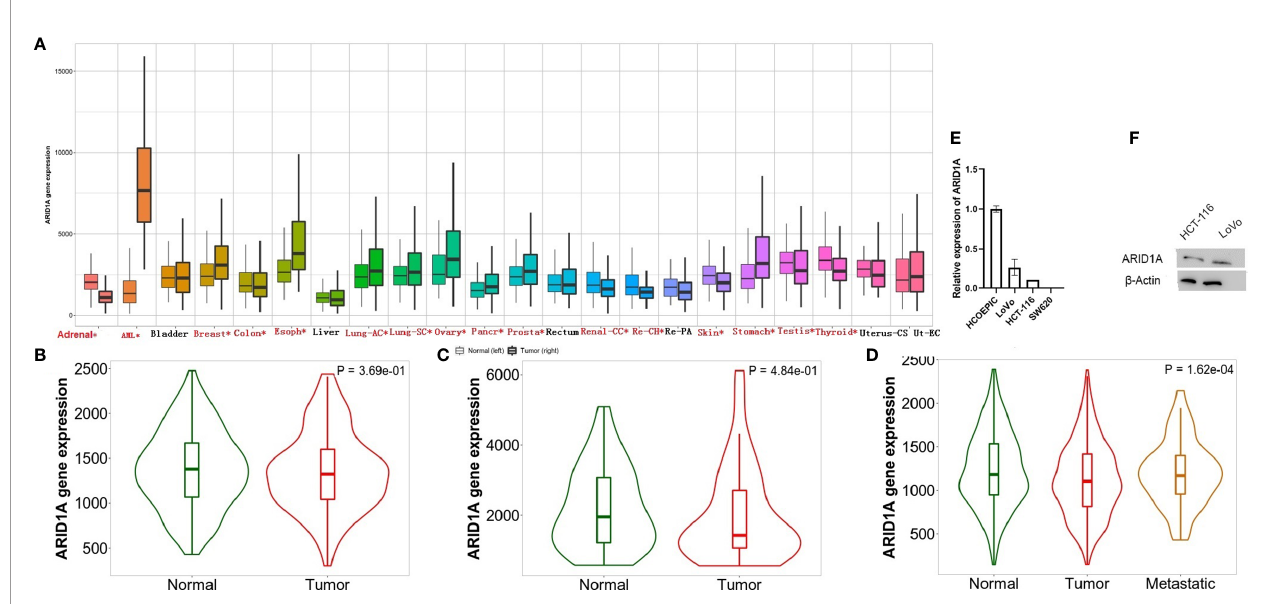
FIGURE 1 | Differential expression of ARID1A. (A) Differential ARID1A expression analysis across several cancer types (signi fi cant differences by the Mann-Whitney U test are marked with red*). Left, normal; right, tumor); (B) ARID1A expression include paired tumor and adjacent normal tissues from Gene chip data; (C) ARID1A expression include paired tumor and adjacent normal tissues from RNA-Seq data; (D) Signi fi cant different expression of ARID1A through metastases, normal, and tumors; (E – F) Experimental veri fi cation of ARID1A mRNA and protein levels in colon cancer cell line using qPCR and western blot,